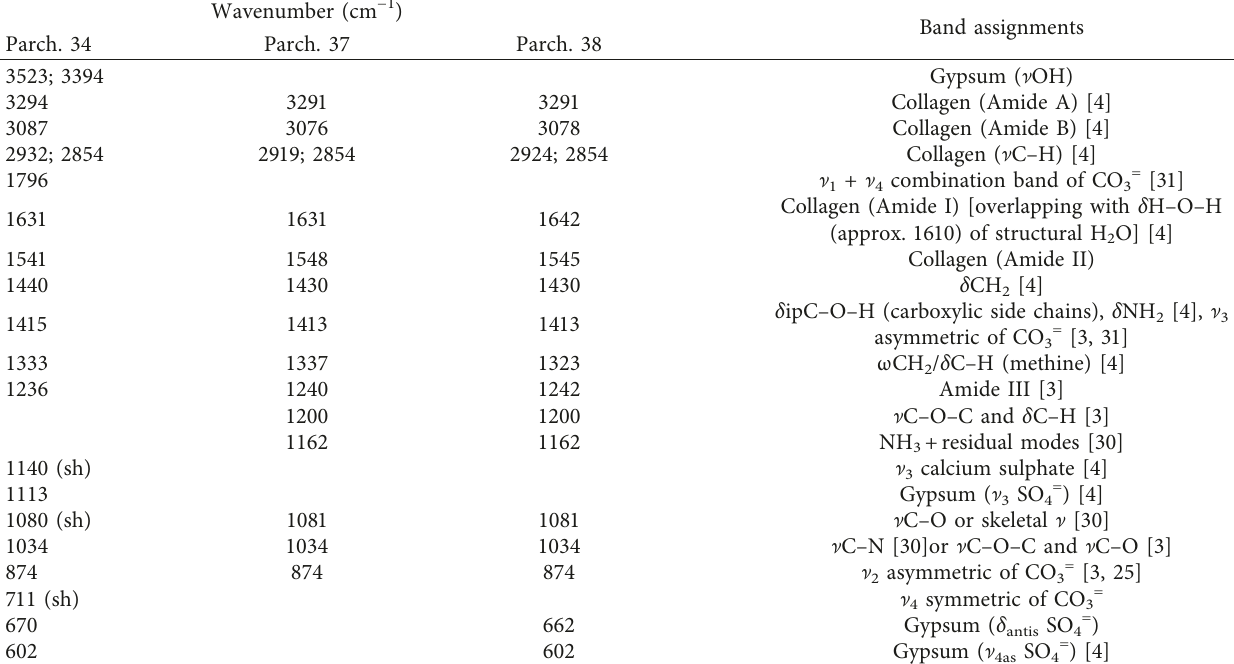
Figure 2: ATR-FTIR spectrum of parchments: (a) Parch. 34, (b) Parch. 37, and (c, d) two areas of Parch. 38. Table 2: Assignment of the main ATR-FTIR bands of the three